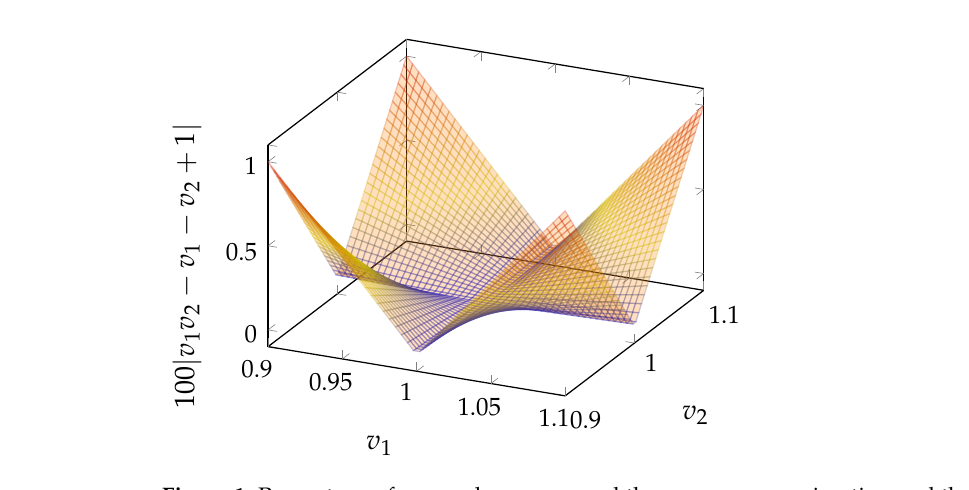
Figure 1. Percentage of error when compared the convex approximation and the exact product of two positive variables around the operative point ( x 0 , y 0 ) = ( 1,1 ) .